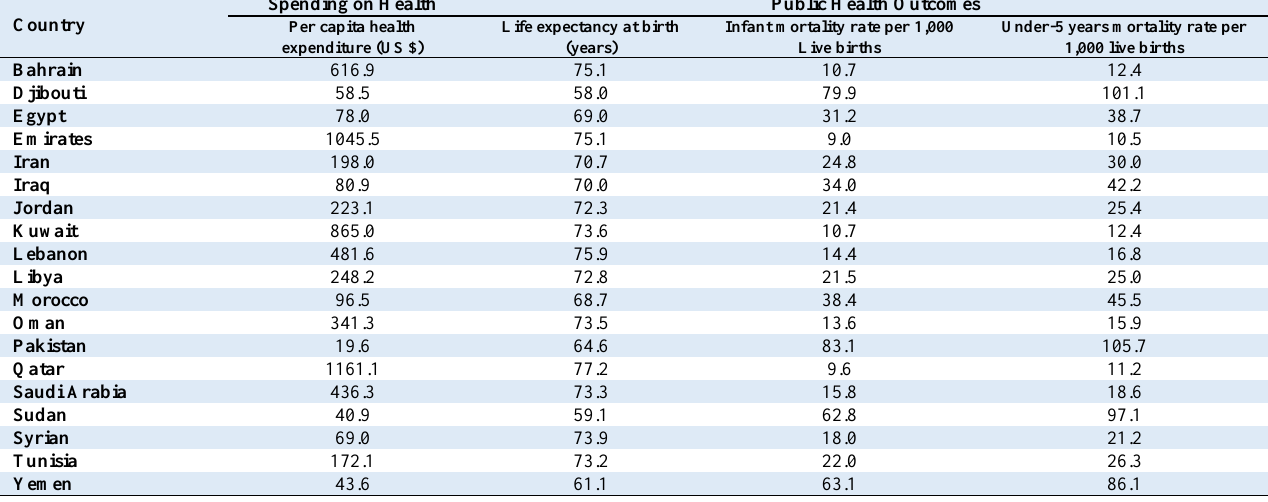
Table 1. Average health spending and public health outcomes in EMR countries during 1995-2011 Spending on Country